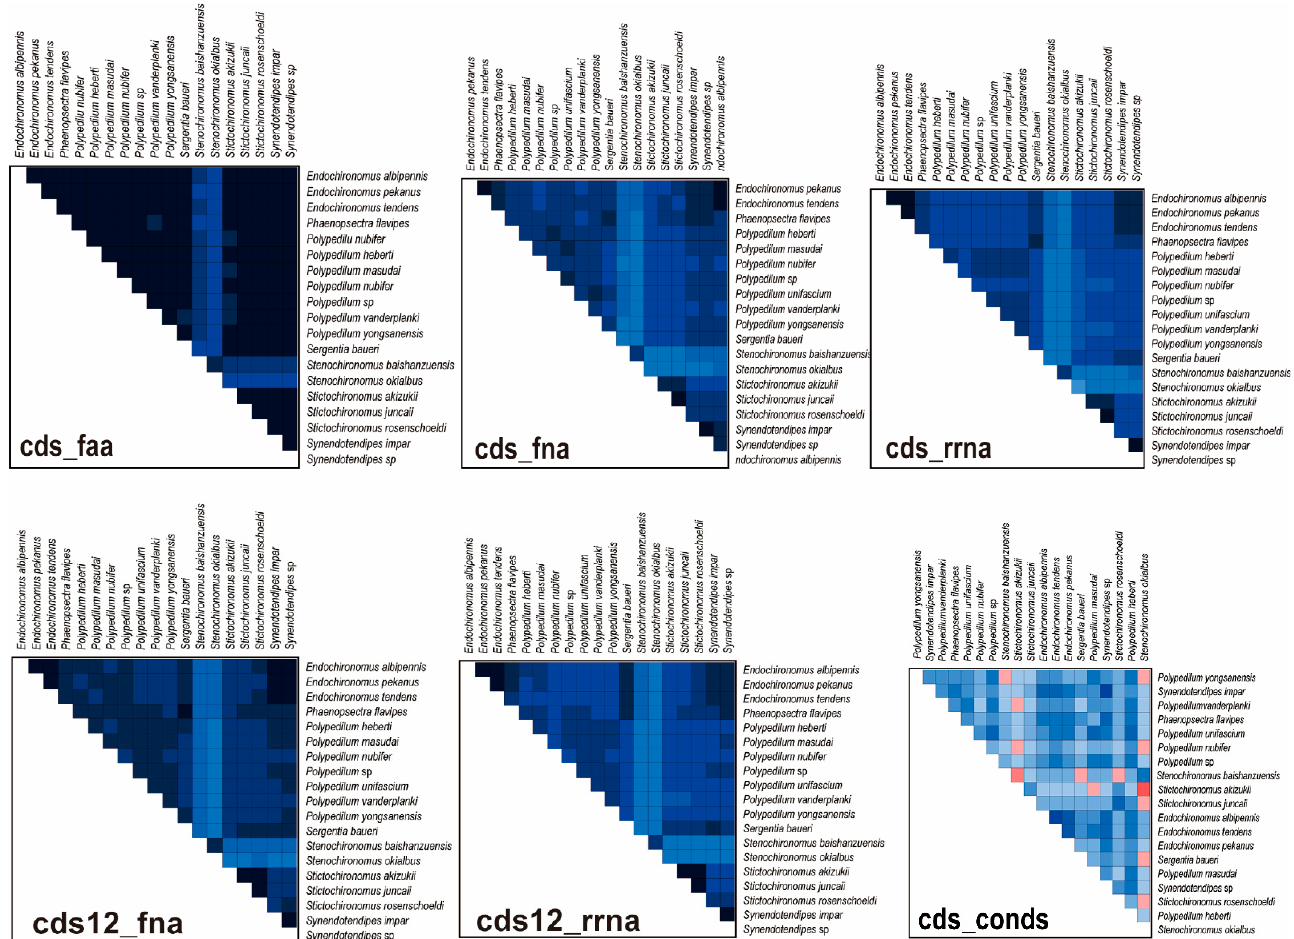
Figure 4. Heterogeneity analysis for different matrices. Colored squares represented pairwise Aliscore values. Score values ranged from − 1 (indicated fully random similarity, dark blue) to +1 (indicated non-random similarity, bright orange, or red).